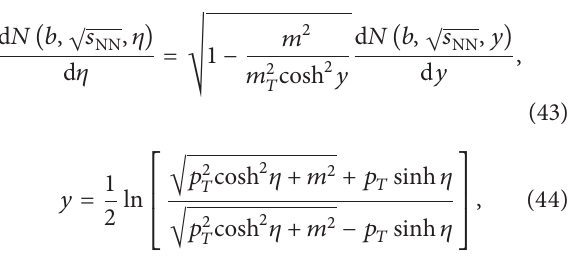
Figure 2: The pseudorapidity distributions of the charged particles produced in different centrality Au-Au collisions at √𝑠 solid dots are the experimental measurements [27]. The dashed curves are the results from evolution-dominated hydrodynamics of (36). The dotted curves are the results from leading particles of (37). The solid curves are the sums of dashed and dotted ones. Having the rapidity distributions of (36) and (37), the pseudorapidity distribution measured in experiments can be expressed as